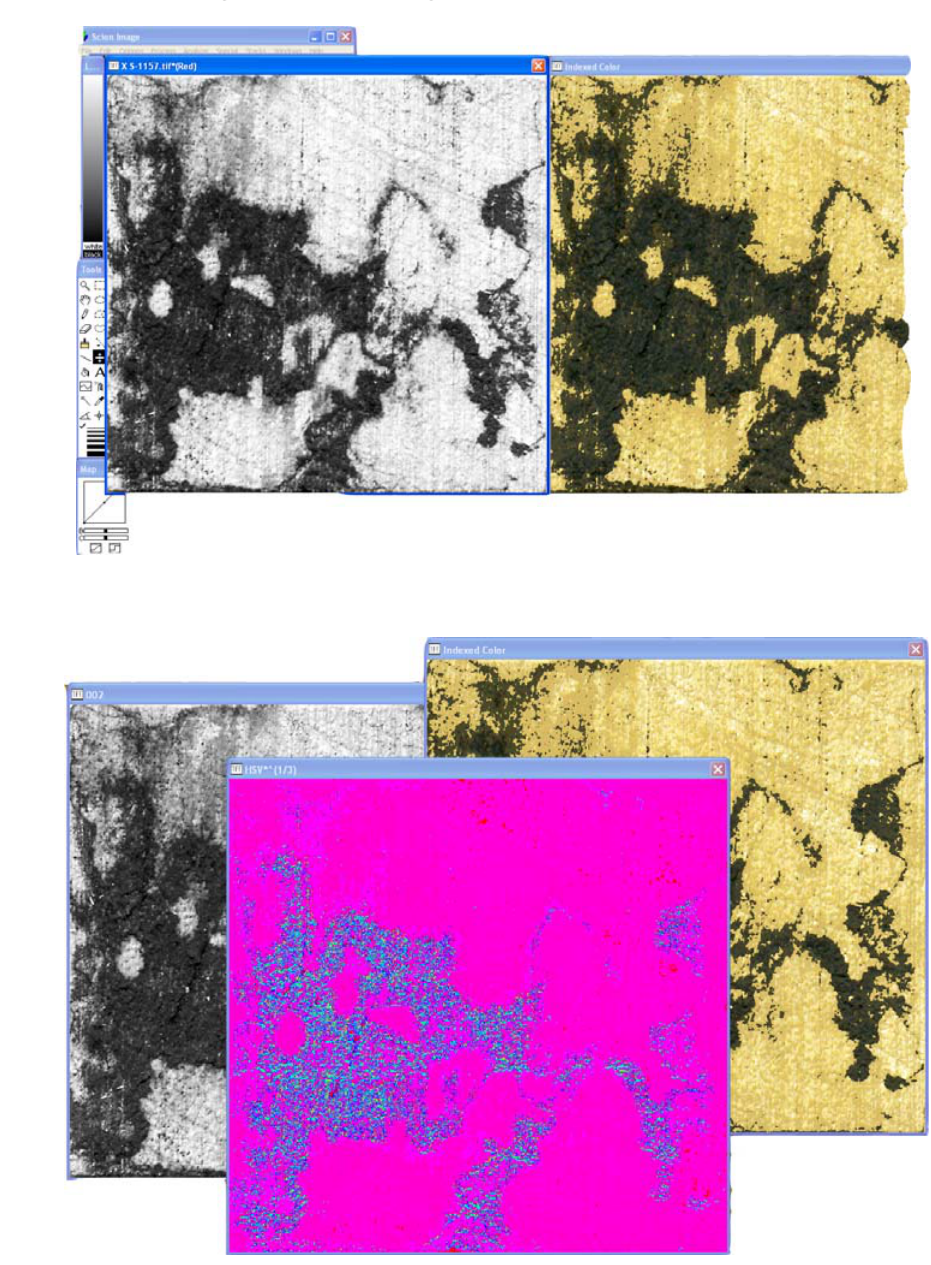
Figure 1. Image preparation for color analysis in Scion Image © . (A): The black and white and original color windows that appear in Scion Image © after loading an image. (B): RGB to HSV conversion on the color image. (C): HSV image stacked to windows. (D): Image math, which adds image 2 (b/w) to image 1